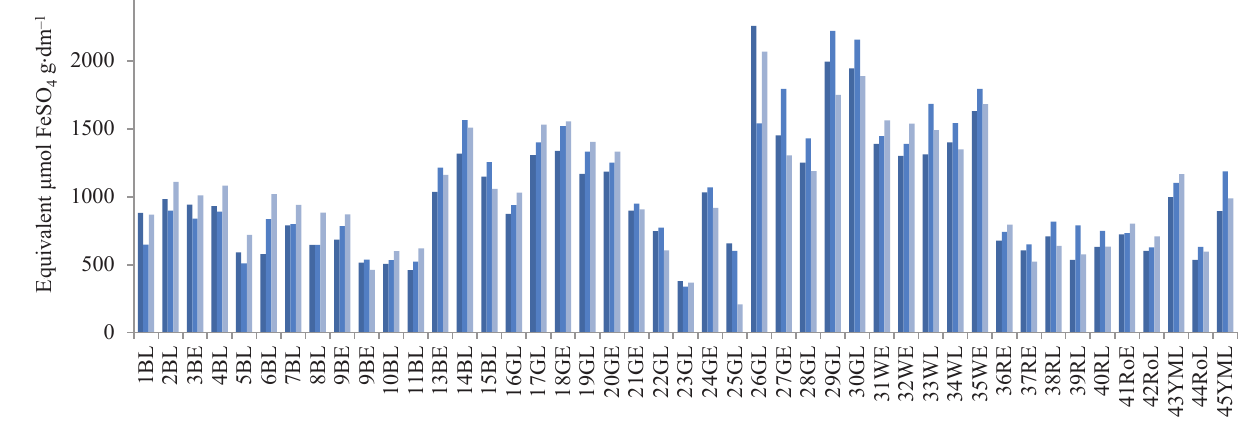
Figure 2 Changes in antioxidant activity of FRAP (E quivalent μmol FeSO